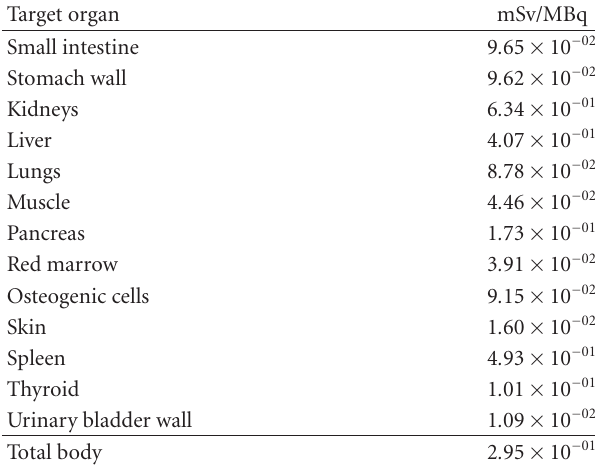
Table 2: Radiation dose estimates of reference adults of 131 I-SHH from